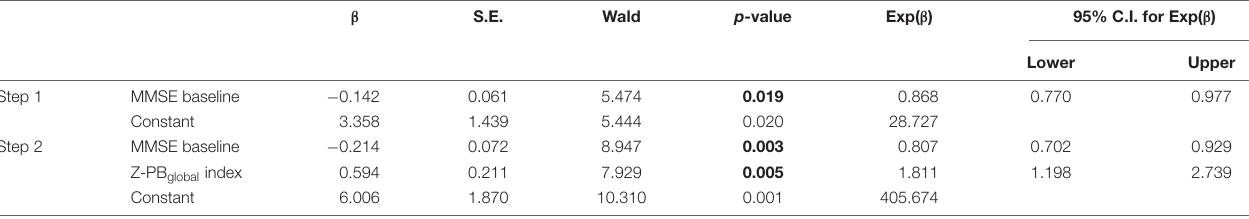
TABLE 3 | Binary logistic regression model to test best predictors of the MMSE change after rehabilitation. β S.E. Wald p -value Exp( β ) 95% C.I. for Exp( β )